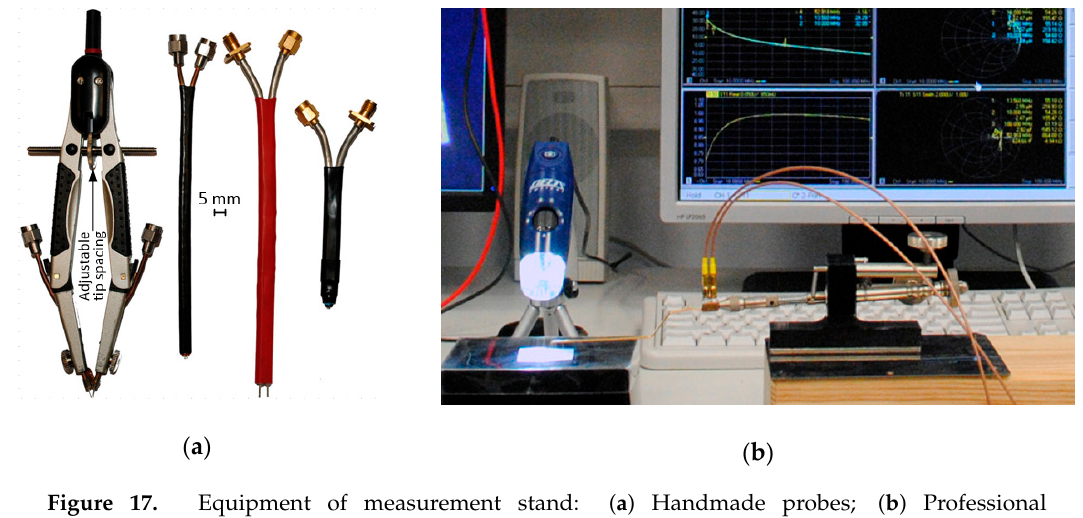
Figure 17. Equipment of measurement stand: ( a ) Handmade probes; ( b ) Professional equipment—precise probes and micromanipulator.